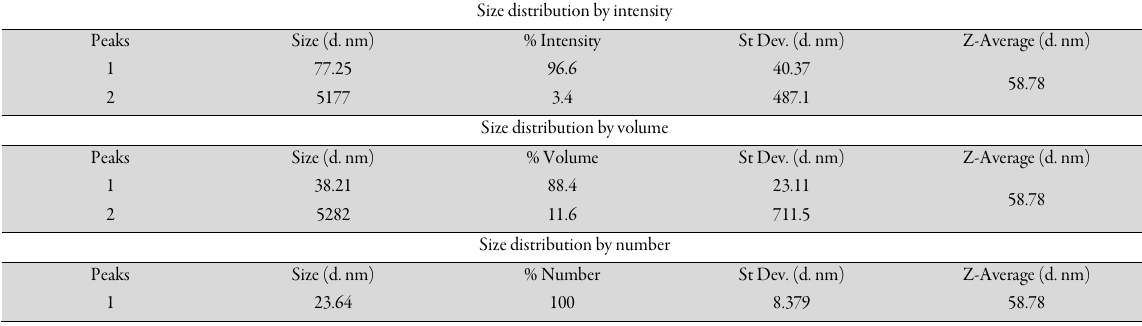
Size distribution by intensity